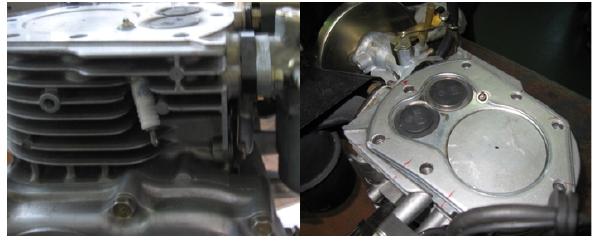
Figure 2: Side and top view of spark plug